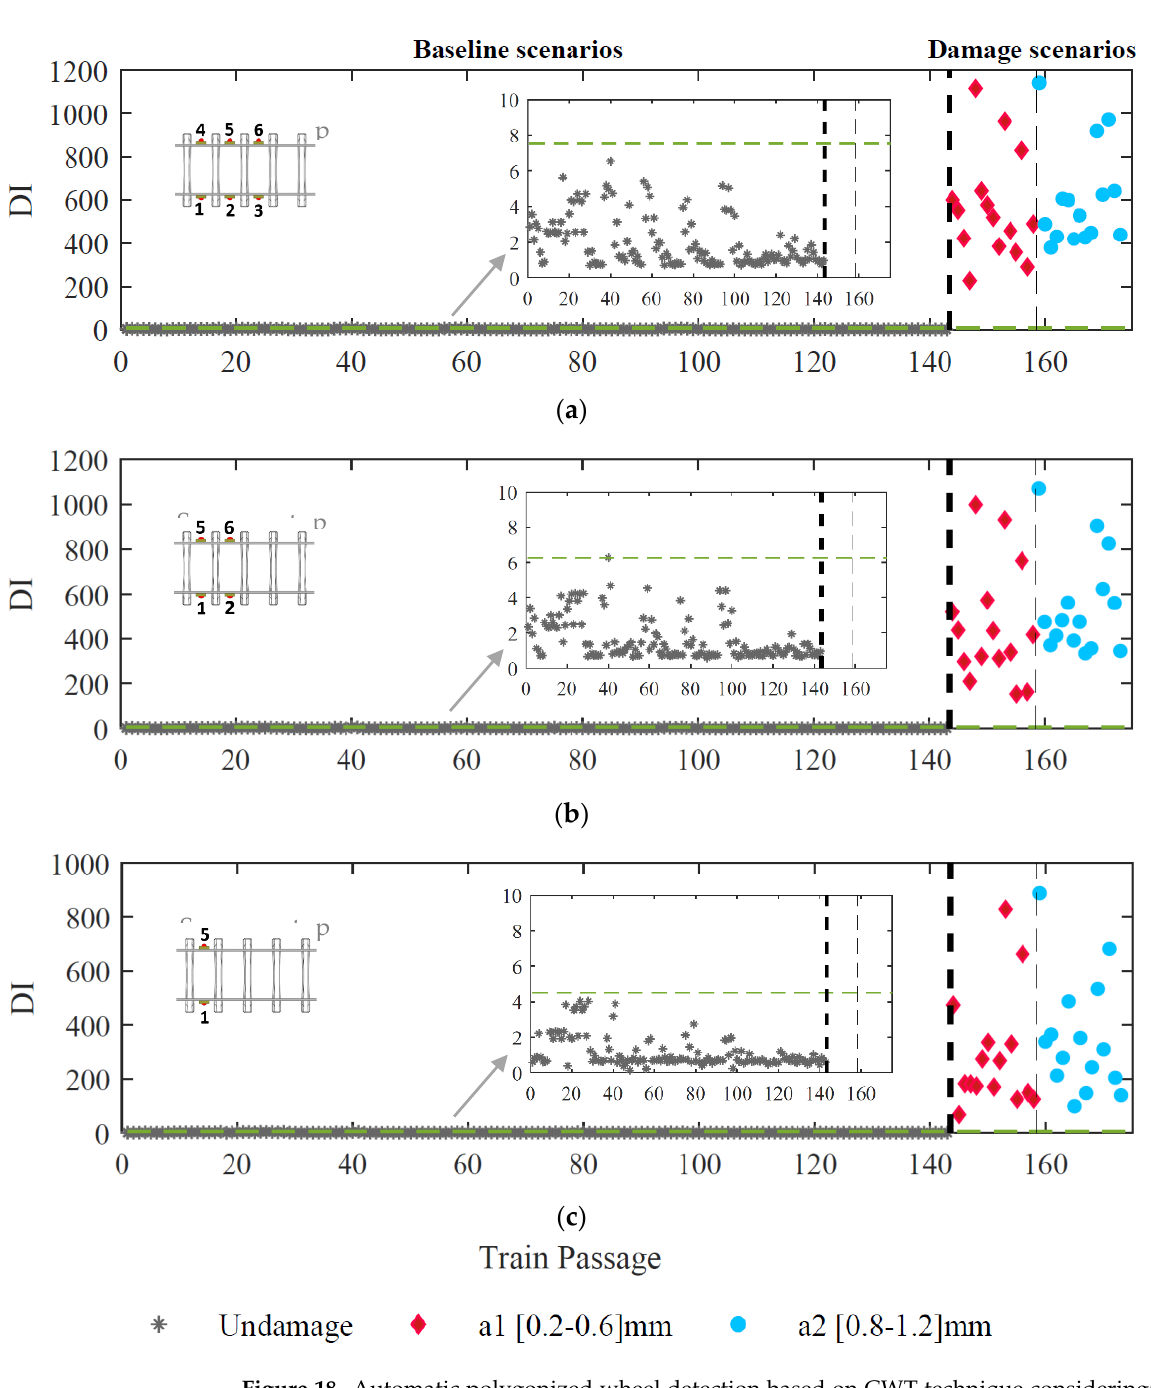
Figure 18. Automatic polygonized wheel detection based on CWT technique considering: ( a ) six sensors, ( b ) four sensors, ( c ) two sensors.